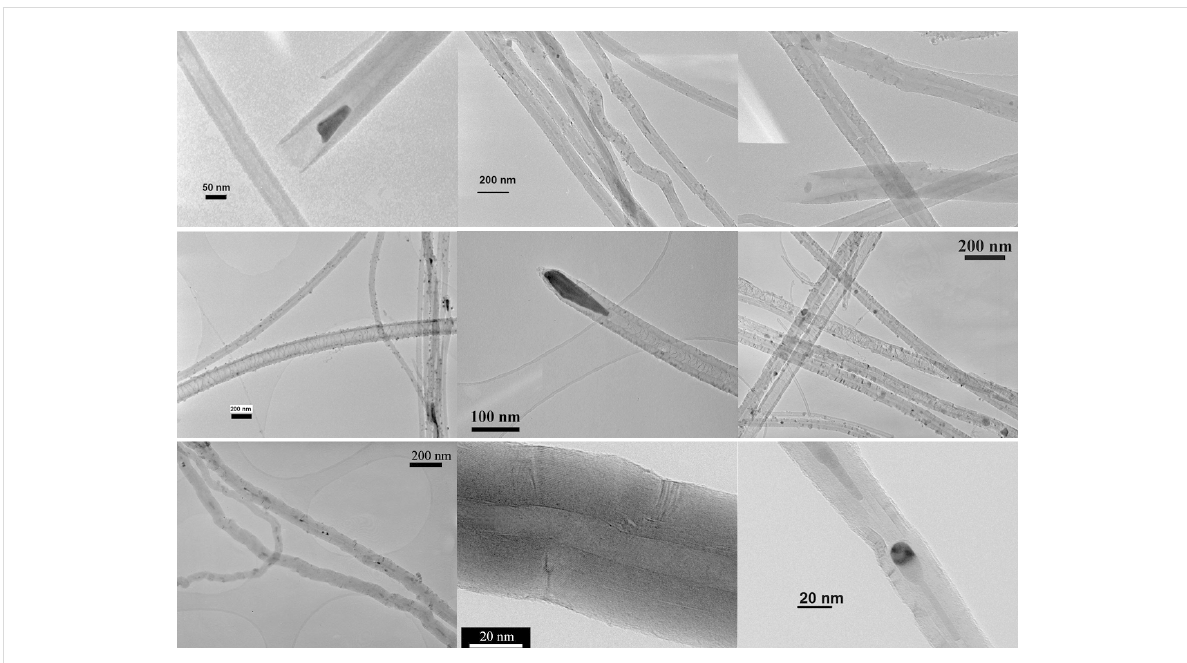
Figure 5: TEM images of: N-CNTs from Synthesis VII ( upper panel ) – straight N-CNTs; magnified views reveal ‘bamboo’-like (cone-like) periodic structures; N-CNTs from Synthesis VIII ( middle panel ) – straight N-CNTs of a compartmental (‘membrane’-like) morphology and bearing large cata- lyst nanoparticle residues at the nanotube ends and smaller ones on the outer walls, occasionally embedded in between the wall filaments; MWCNTs from Ref. Synthesis ( lower panel ) – nanotubes composed of irregular walls full of corrugations and kinks with a core discontinuously filled with metallic nanoparticles.